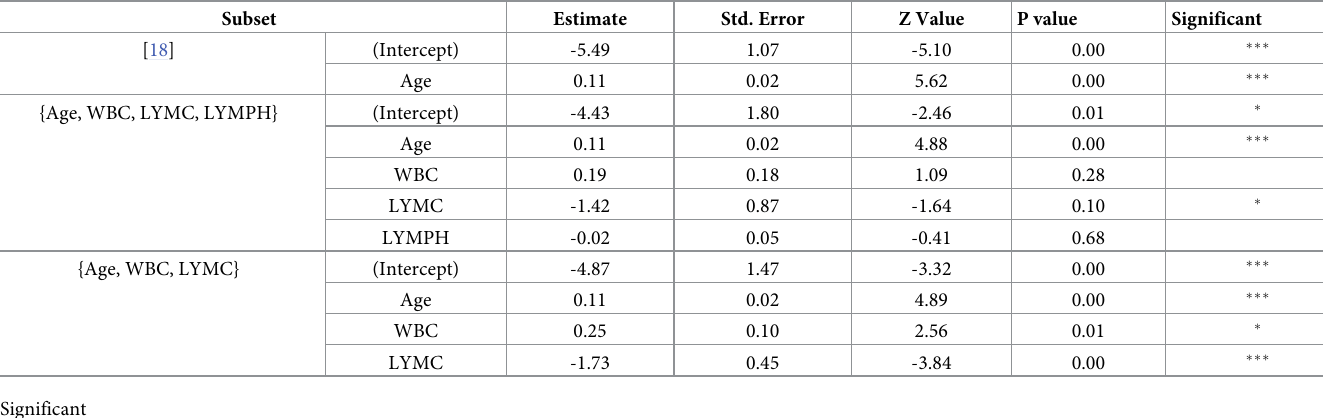
Table 4. The joint significance of different